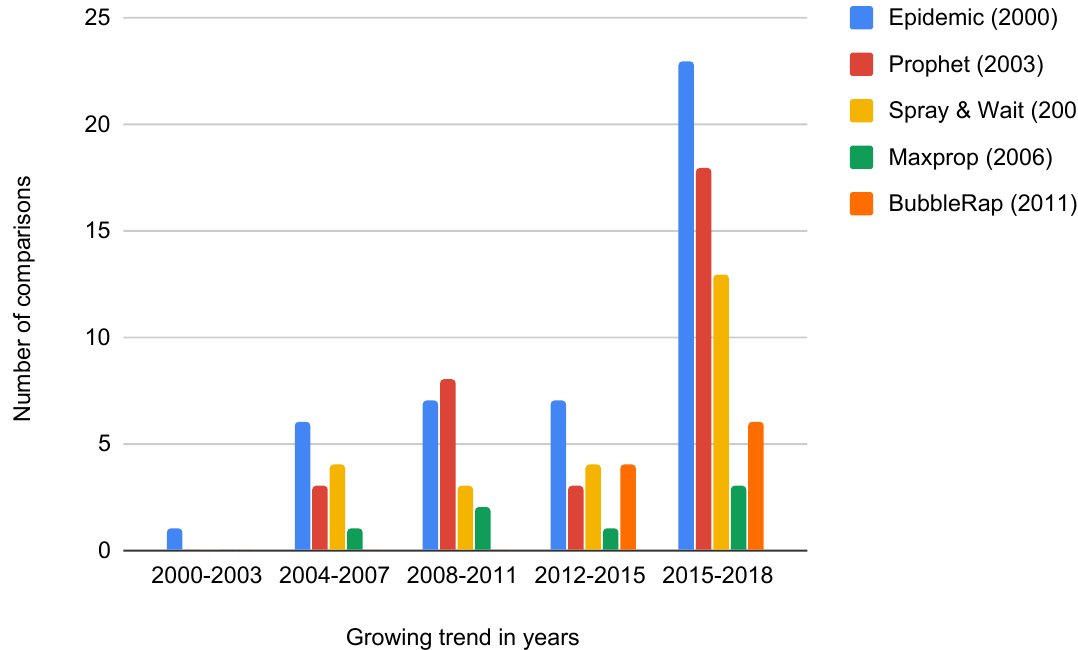
Figure 4. Comparative studies of the surveyed OppNet protocols with the most compared OppNet protocols and their